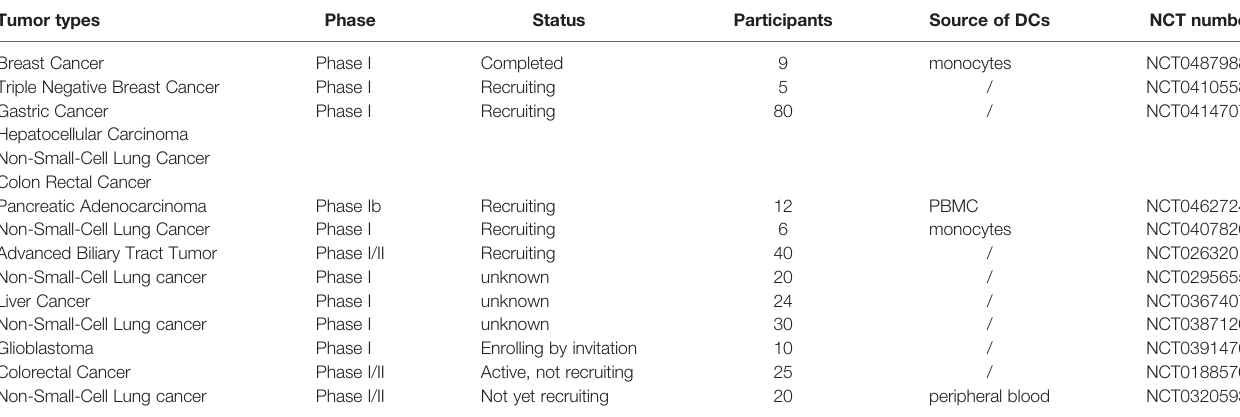
TABLE 3 | The clinical application of personalized neoantigen-pulsed DC vaccines. Tumor